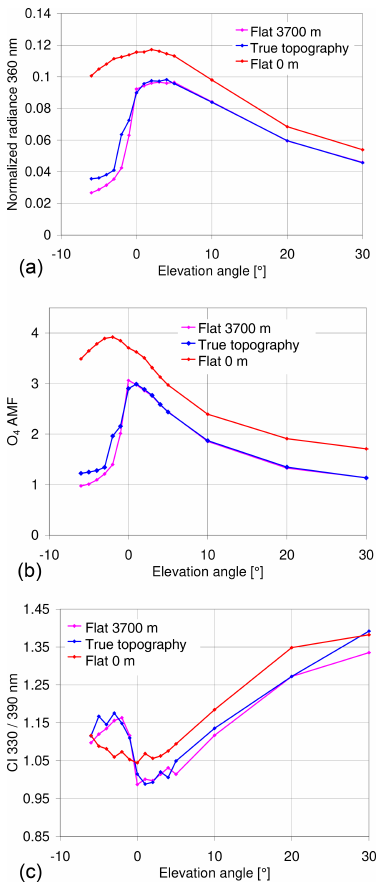
Figure 5. Simulation results of the radiance (a) , O 4 AMF (b) , and color index (c) for different choices of the surface topogra- phy as function of the elevation angle (including negative eleva- tion angles). Simulation results are for summer noontime (see also Fig.